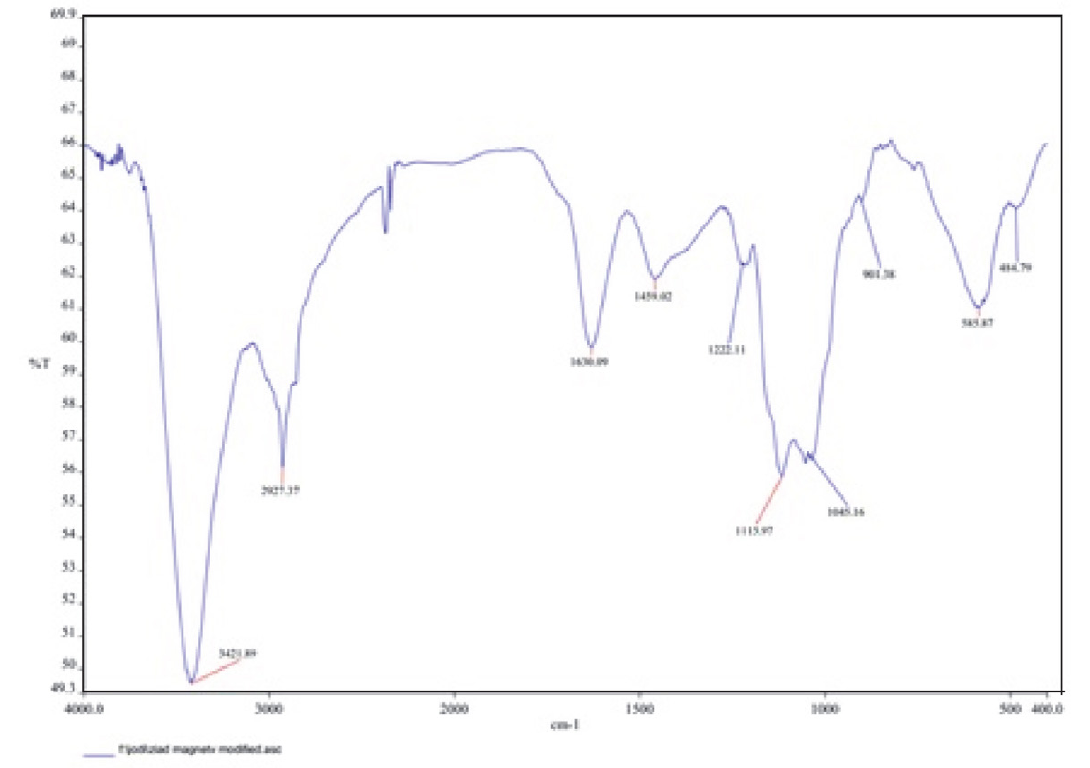
Figure 2. FT-IR spectrum of Fe 3 O 4 @PyHBr 3 MNP